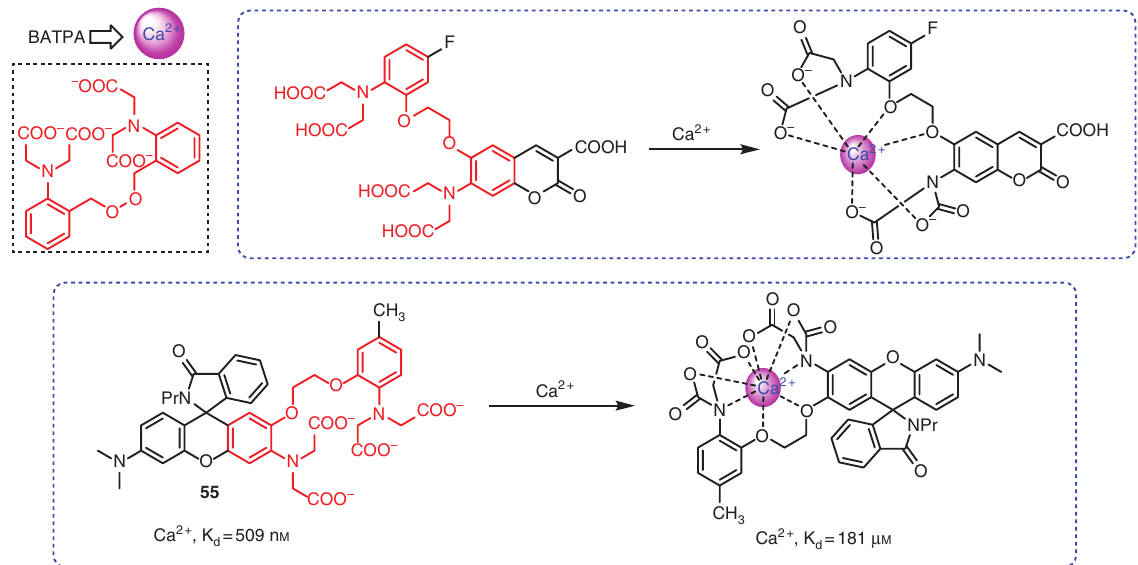
Figure 36: Development of BAPTA structure for Ca 2 +